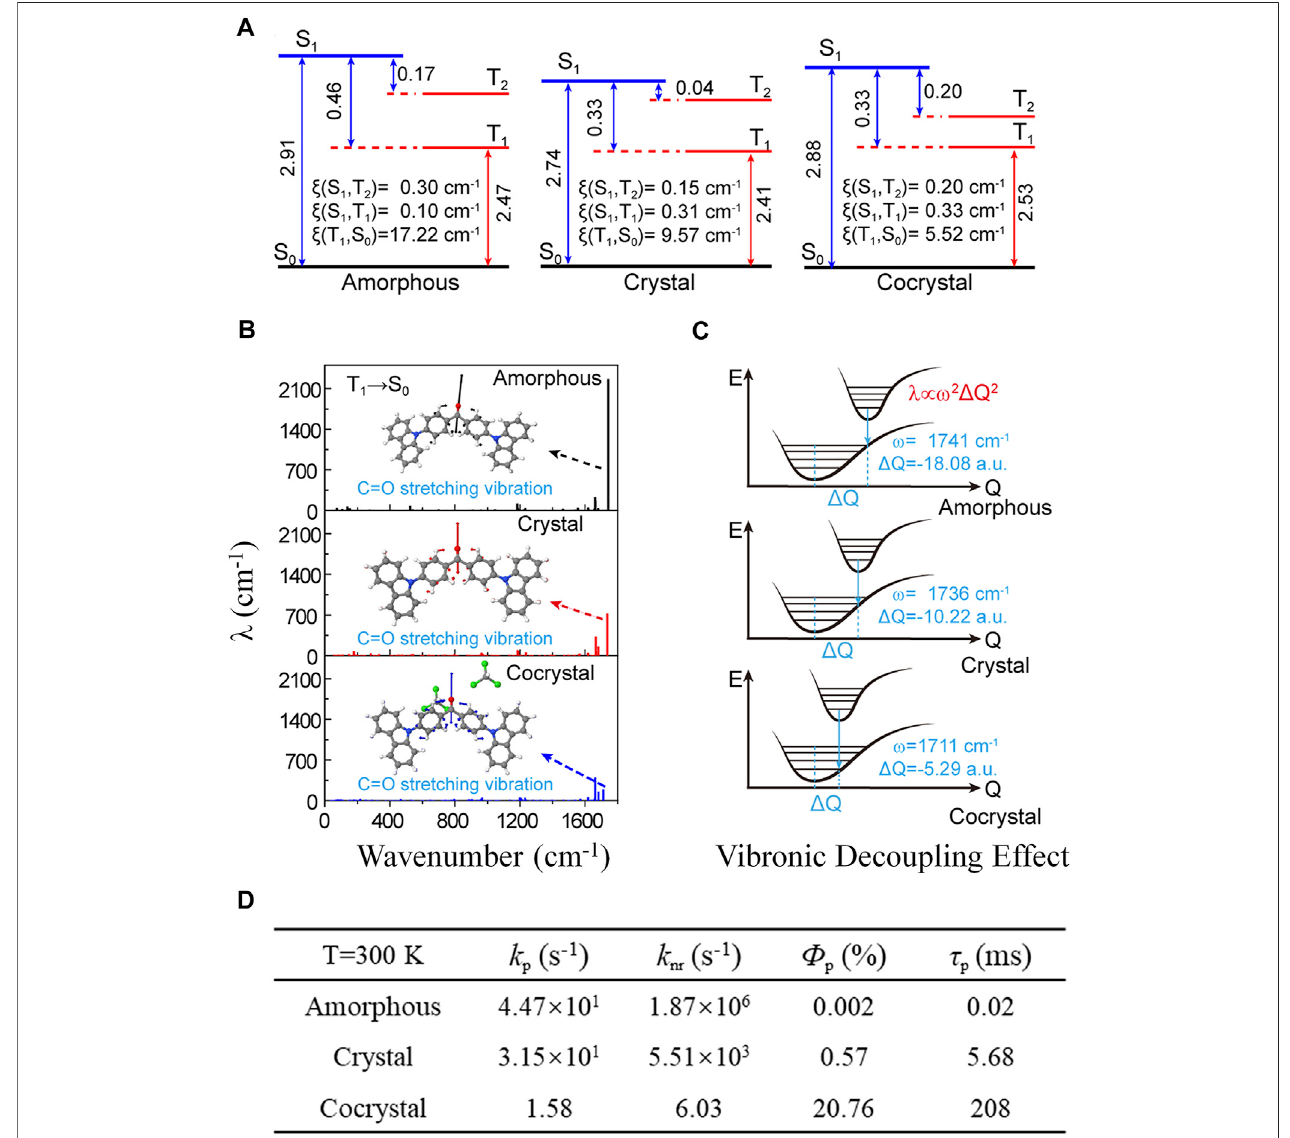
FIGURE 6 | (A,B) Calculated spin-orbital coupling coef fi cients ( ξ ) and reorganization energies of low-lying excited states in amorphous, crystal, and cocrystal phases of Cz2BP. (C) Illustration of the vibronic decoupling effect of the electron and C (cid:1) O stretching vibration. (D) Calculated key parameters ( k p , k nr , V p and τ p ) of the exciton energy decay process in amorphous, crystal, and cocrystal. (Reproduced with permission from Ma et al. (2019); Copyright 2019 American Chemical Society).